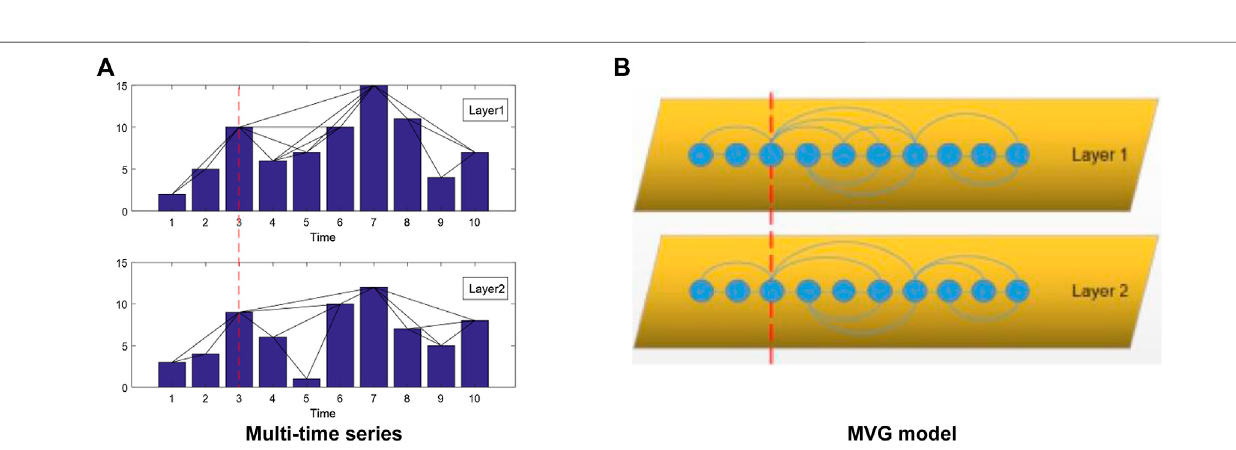
FIGURE 2 | An illustration of the